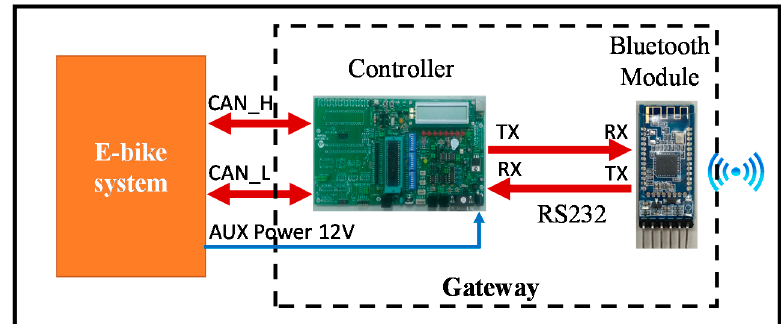
Figure 2. Hardware block diagram.